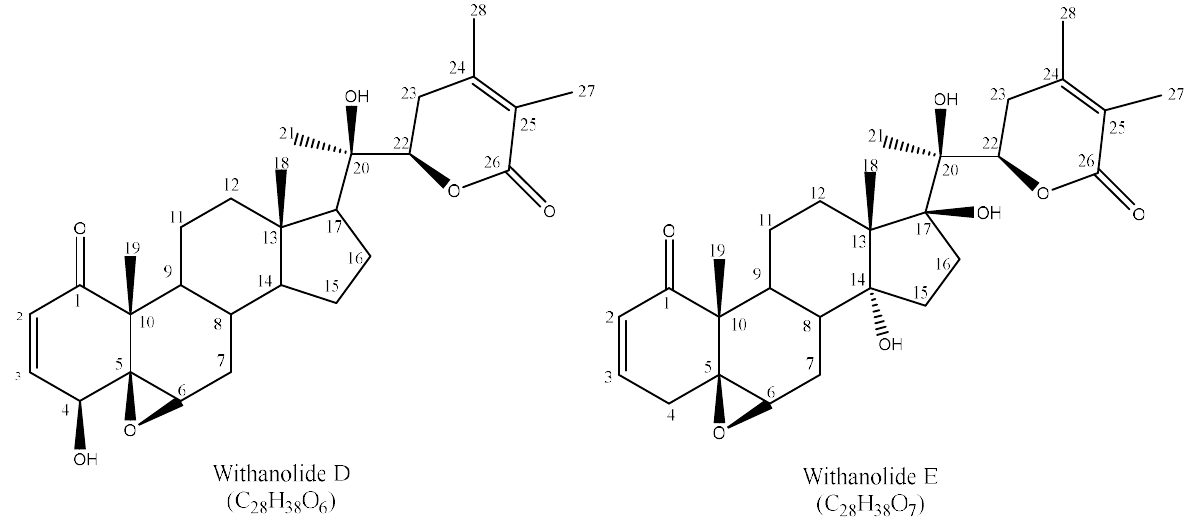
Figure 1. UPLC QTOF-ESI MS extracted ion chromatograms of withanolides from P. peruviana husks and fruits.